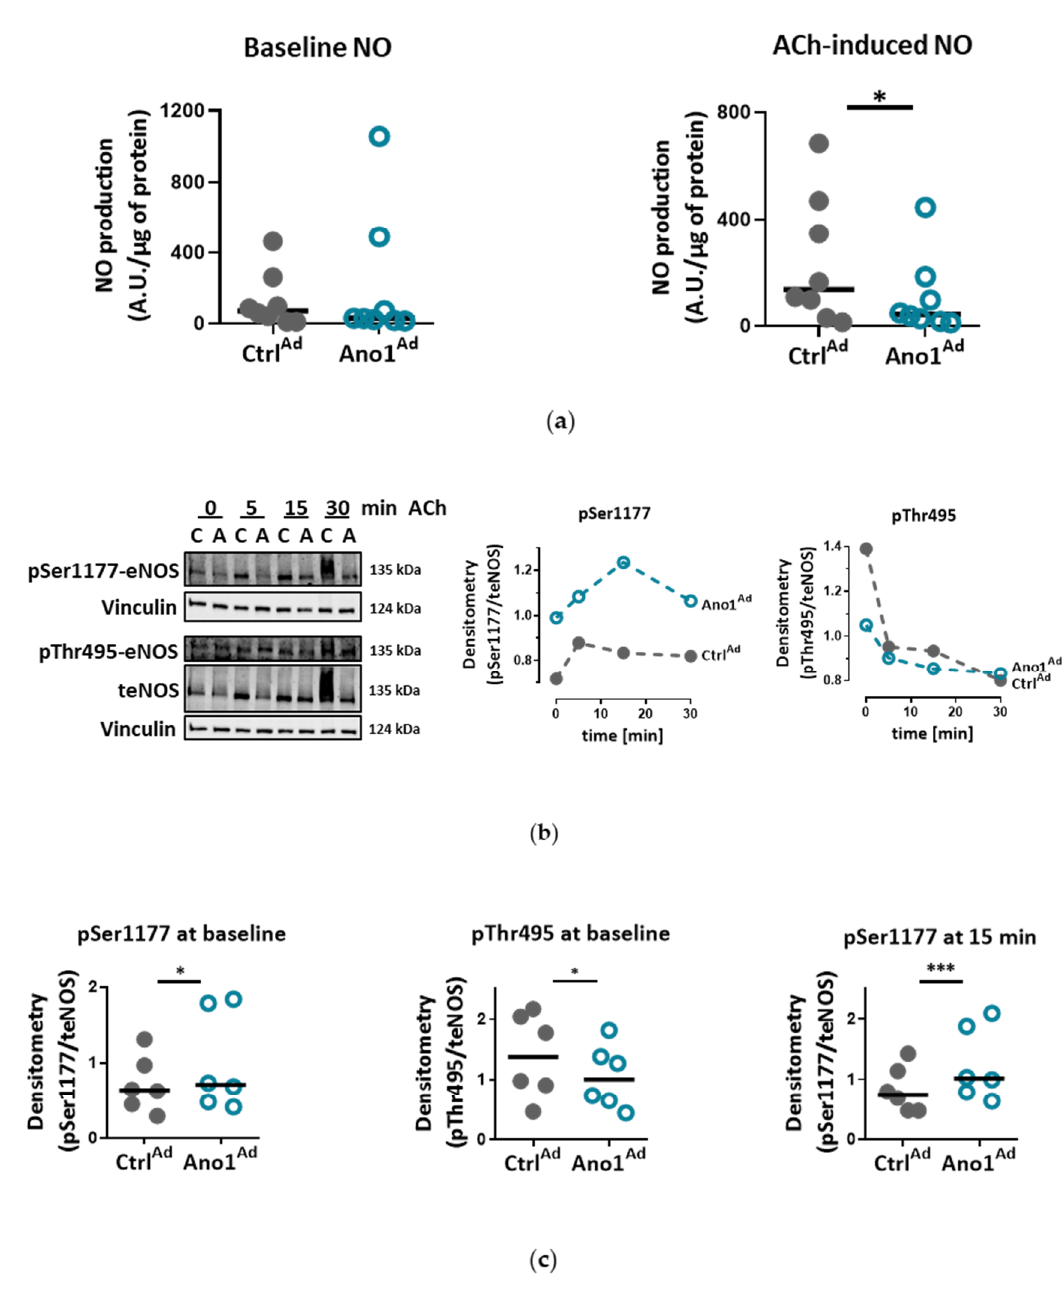
Figure 8. Elevated TMEM16A activity disturbs eNOS activation: ( a ) Noninduced nitric oxide levels and ACh-induced nitric oxide production of control (Ctrl Ad ) and TMEM16A-overexpressing (Ano1 Ad ) human PAECs. Figures were generated with 8 sets of experiments with quadruplicate in each group and normalized to protein content. ( b ) Western blots showing ACh-induced changes in eNOS phosphorylation of Ctrl Ad and Ano1 Ad -infected donor PAECs with quantification following the eNOS phosphorylation pattern at activatory Ser1177 and inhibitory Thr495 sites after 5, 15 and 30 min of ACh stimulation. ( c ) Quantification of basal, noninduced level of eNOS phosphorylation at Ser1177 and Thr495 as well as phosphorylation of Ser1177 15 min after ACh stimulation. Figures were generated with 6 samples. * p < 0.05, *** p < 0.001, ratio-paired